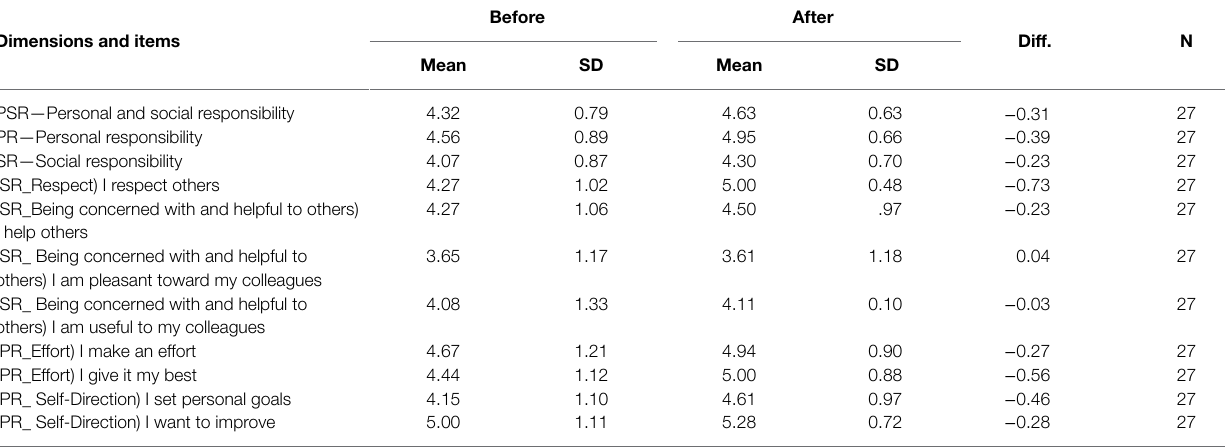
TABLE 5 | Descriptive analysis of the mean and standard deviation concerning the dimension of PSR of the intervention group. Dimensions and items